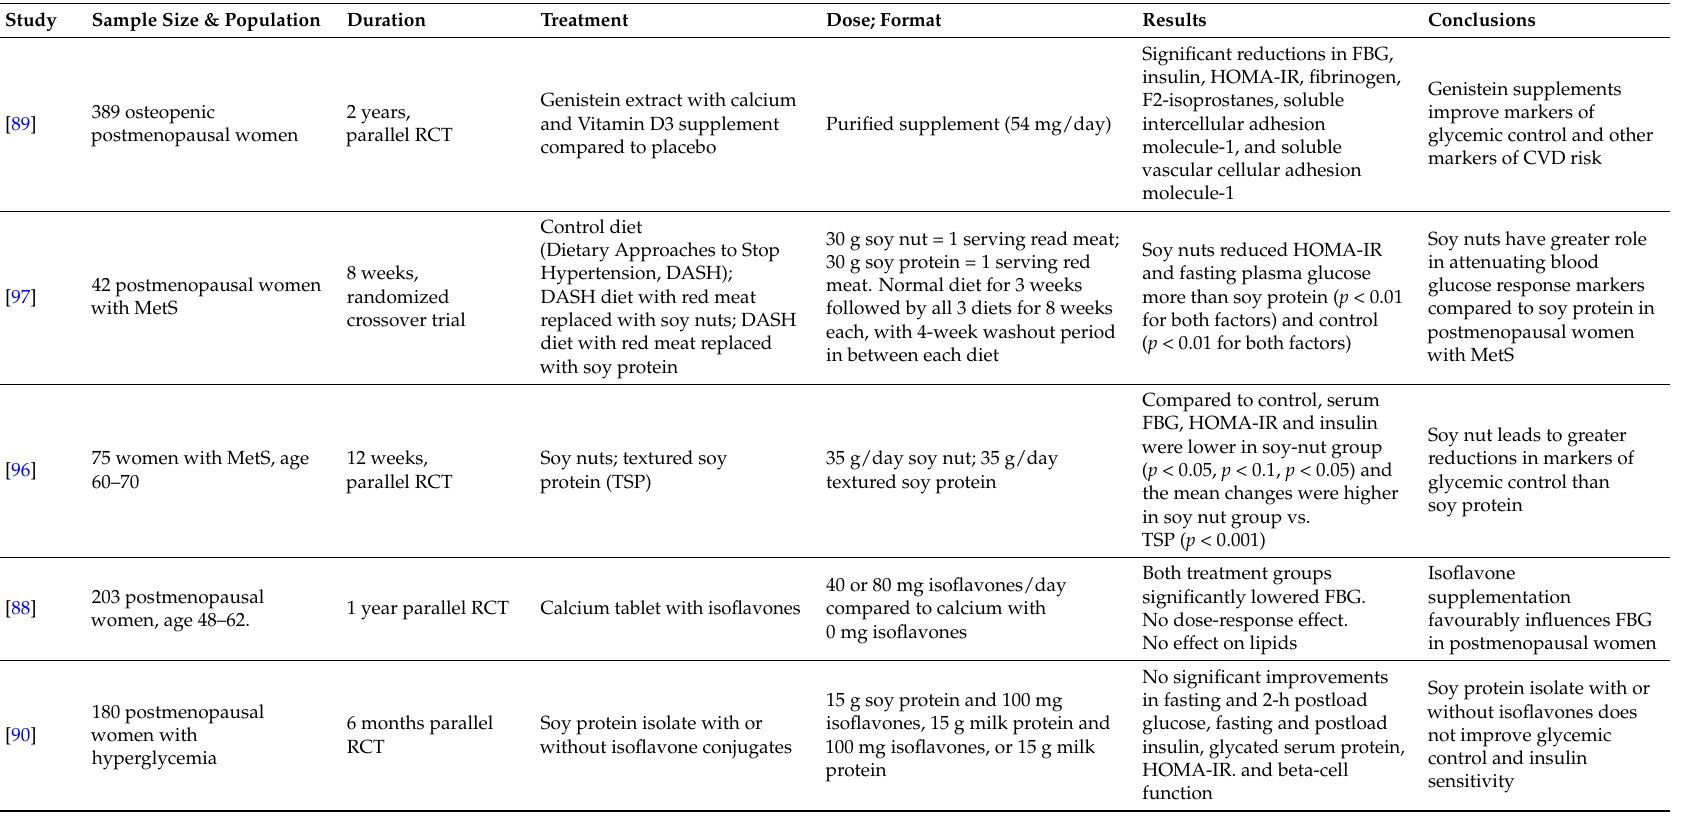
Table 2. Summary findings from randomized control trials based on the impact of soy on